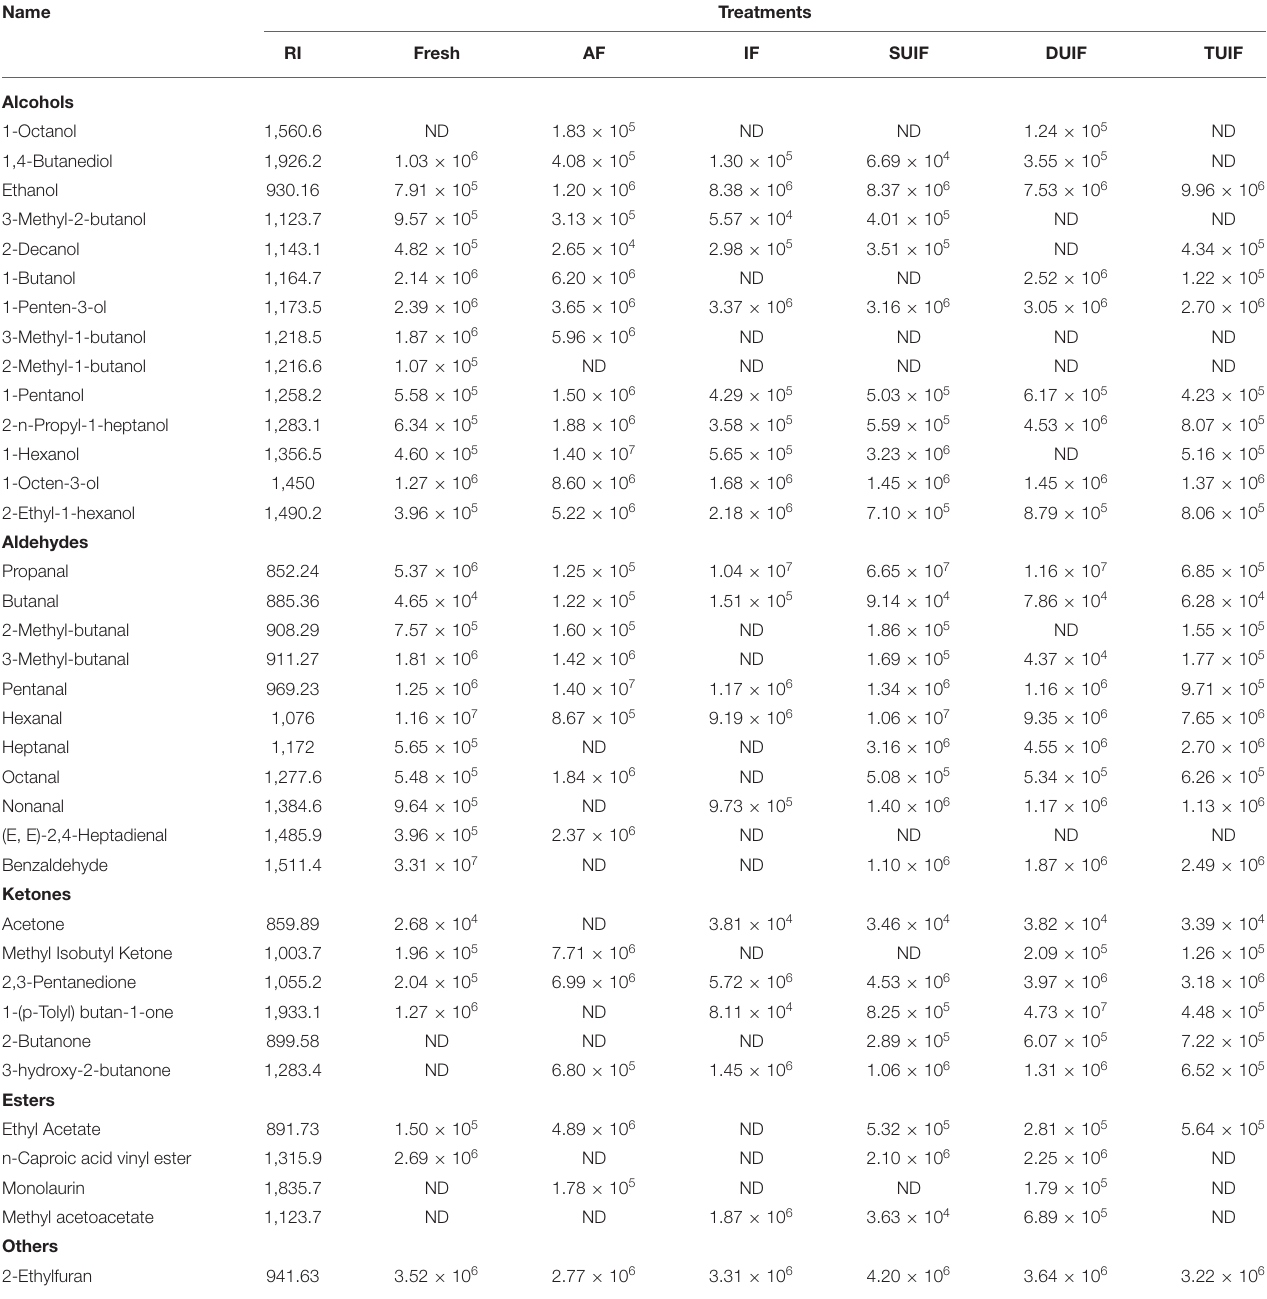
TABLE 1 | Retention index and area of main volatile compounds identified in large yellow croaker under different freezing